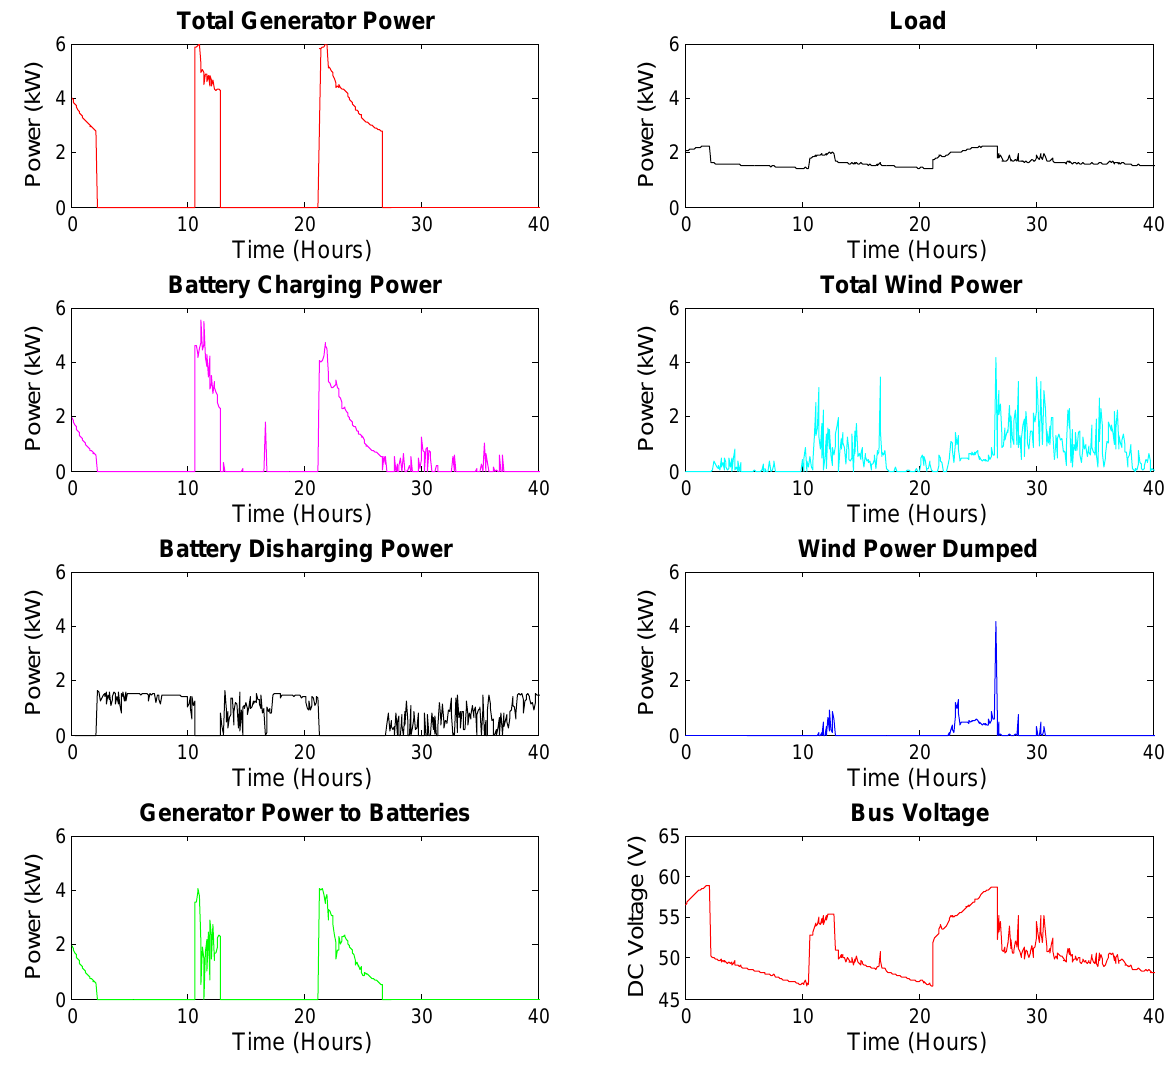
Figure 2. Energy flow in the test hybrid system with renewable energy sources